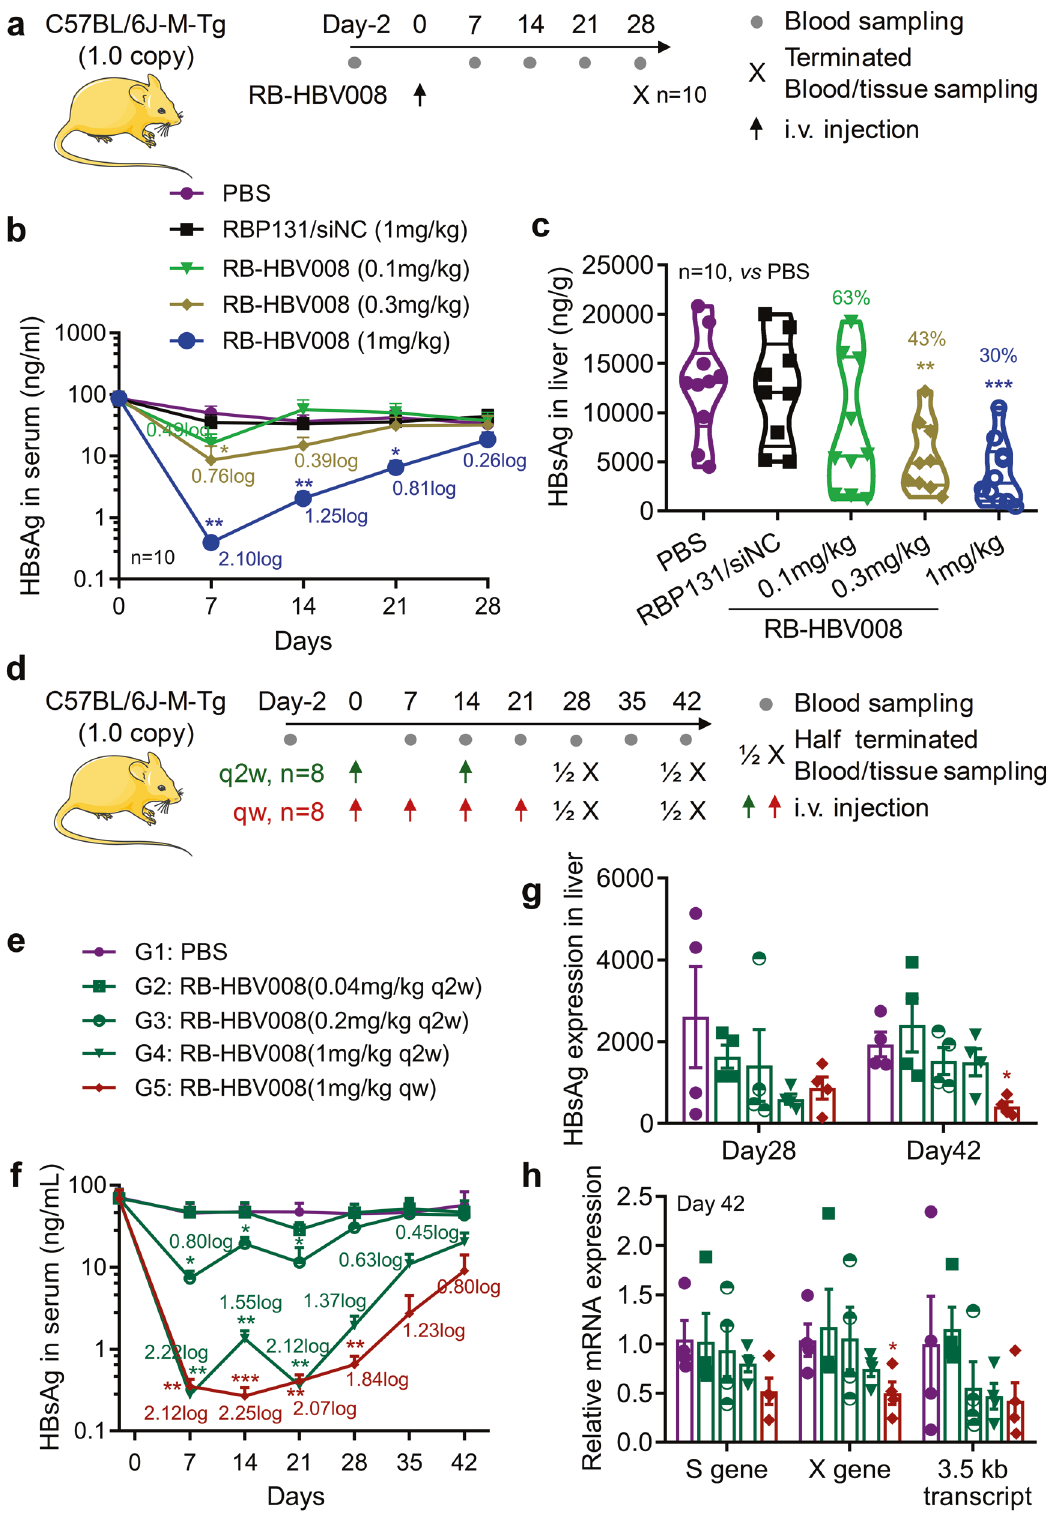
Fig. 4 Ef fi cacy of RB-HBV008 in C57BL/6J-M-Tg (HBV C1.0) mouse model. a Treatment schedule of “ 1.0M-SD ” study. b Level of HBsAg in serum during the treatment course. c Expression of HBsAg in the liver tissues was analyzed at day 28. d Treatment and sampling schedule of “